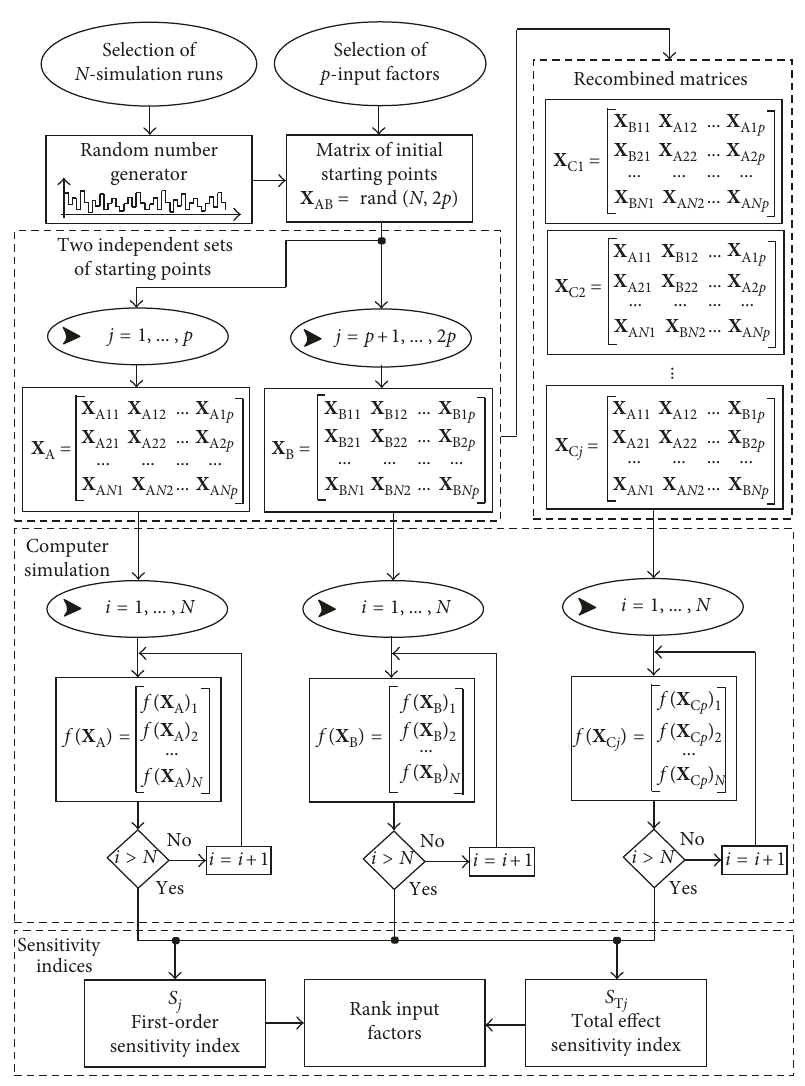
Figure 3: Block diagram for the sensitivity analysis of vibration reduction